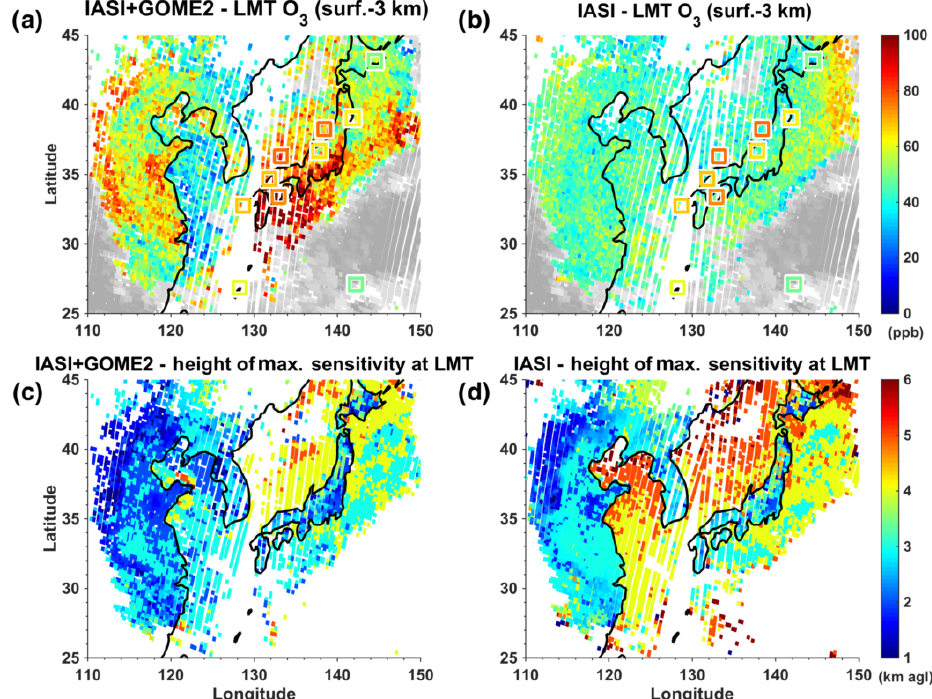
Figure 3. Example of comparison on 9 April 2009 over East Asia of (a) IASI + GOME2 and (b) IASI retrievals of LMT ozone (from the surface up to 3kma . s . l . in both cases) with surface observations (squares in panels a and b ). Grey-shaded pixels show cloud fractions above 0.3, as derived from the GOME-2 Fresco algorithm. Heights of maximum sensitivity of the LMT ozone partial columns are shown for (c) IASI + GOME2 and (d)